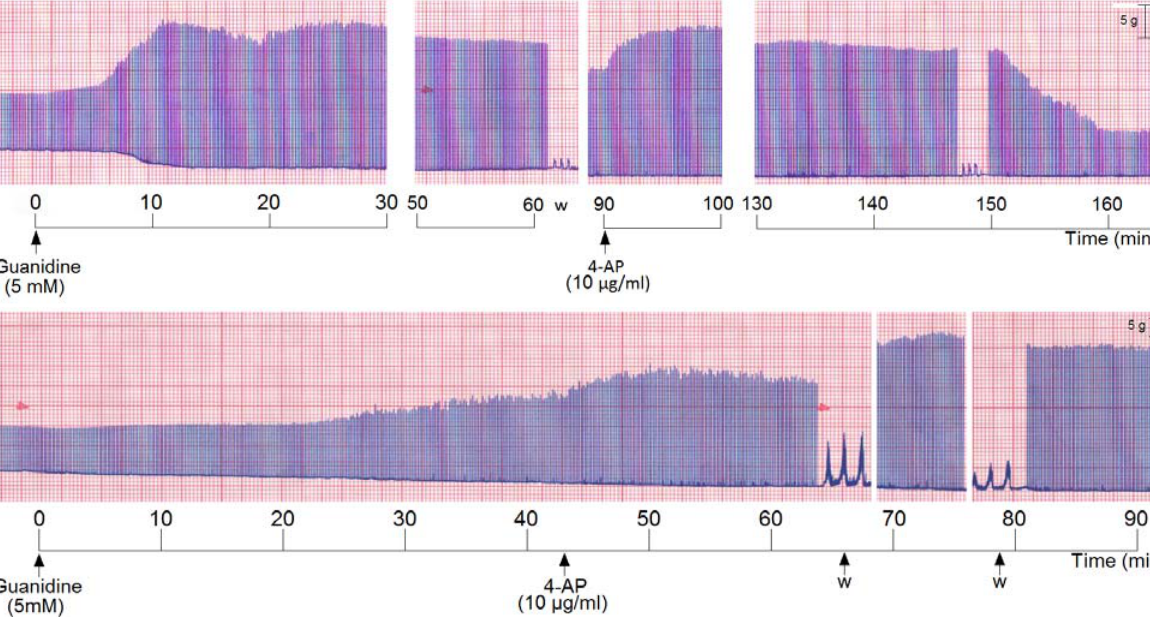
Figure 5. Representative recordings (of four experiments each) from indirectly stimulated PND incubated with 5 mM guanidine, followed by washing (w) and subsequent addition of 4-aminopiridinte (4-AP) and another washing after 60 min additional incubation (upper recording); in the lower recording there was no guanidine removal by washing before 4-AP